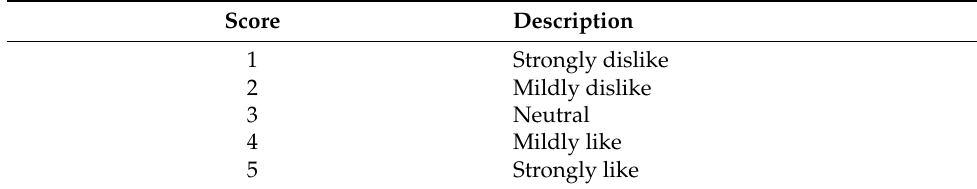
Table 4. Description of scores. Score